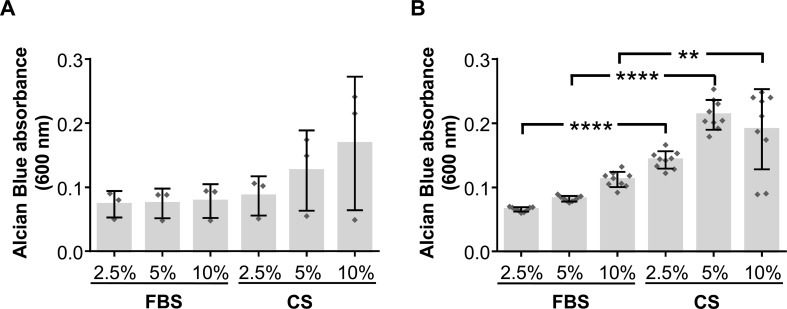
Chondrogenic differentiation potential of hAdMSCs cultured in the presence of FBS or CS. Cells were cultured in the presence of FBS or CS at different concentrations (2.5, 5, and 10%) for 15 days in standard medium (DMEM supplemented with 1% penicillin/streptomycin and 1% glutamine) as negative control (A) or in chondrogenic differentiation specific medium (B). Chondrogenic differentiation was confirmed by Alcian Blue 8GX staining that evidences the presence of accumulated glycosaminoglycans. For the quantification of the differentiation degree, cells were lysed to release the colorant, which was spectrophotometrically measured at 600 nm. Graphs represent individual values (A, n = 3; B, n = 9) as well as mean ± SD of three independently performed experiments. Data were statistically analyzed using a one-way ANOVA test followed by a Fisher’s least significant difference test to compare equivalent concentrations of CS and FBS. **p ≤ 0.01; ****p ≤ 0.0001.